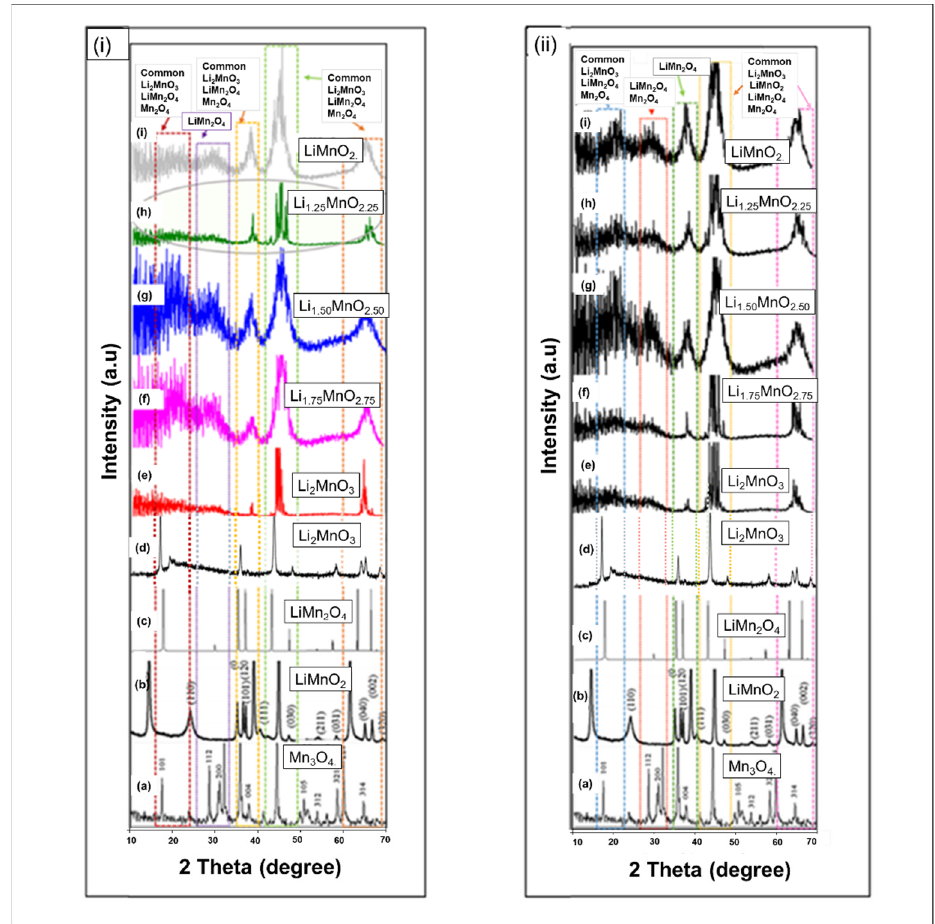
Figure 6. [ i ] XRDs graphs for the ( a ) Mn 3 O 4 reproduced with permission from Ref. [28]. 2017. Water Conservation Science and Engineering, ( b ) LiMnO 2 reprodused with permission from Ref. [29]. 2008. Journal of Solid State Electrochemistry, ( c ) LiMn 2 O 4 [29], ( d ) Li 2 MnO 3 reproduced with permission from Ref. [15]. 2018. Ionics., superimposed with simulated XRDs calculated from the nanoporous 73 Å, ( e ) Li 2 MnO 3 , ( f ) Li 1.75 MnO 2.75 , ( g ) Li 1.50 MnO 2.50 , ( h ) Li 1.25 MnO 2.25 , and ( i ) LiMnO 2 . [ ii ] diffraction peaks for the the ( a ) Mn 3 O 4 [28], ( b ) LiMnO 2 , ( c ) LiMn 2 O 4 [29], ( d )Li 2 MnO 3 [15], superimposed with simulated XRDs calculated from nanoporous 75 Å, ( e ) Li 2 MnO 3 , ( f ) Li 1.75 MnO 2.75 , ( g ) Li 1.50 MnO 2.50 , ( h ) Li 1.25 MnO 2.25 , and ( i ) LiMnO 2 .